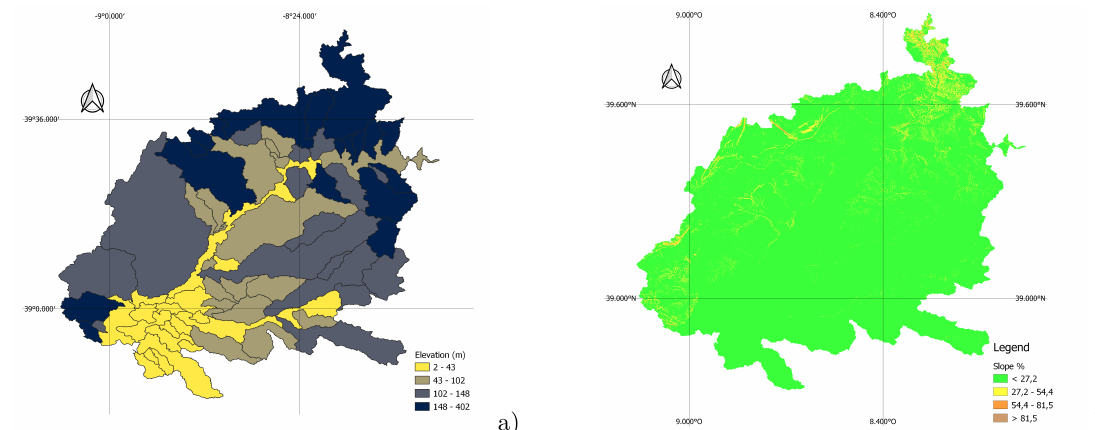
Figure 9. Data collection of vulnerability factors: a) Elevation and b) Slope.